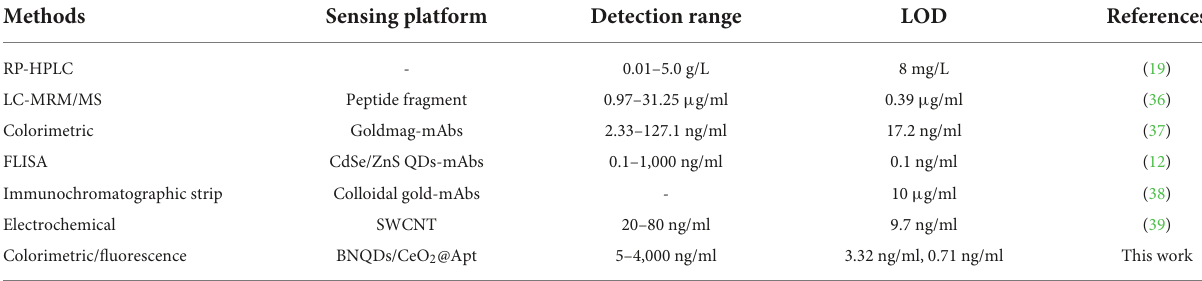
TABLE 1 Comparison of the developed method with other different detection methods for α -lactalbumin ( α -La) determination.